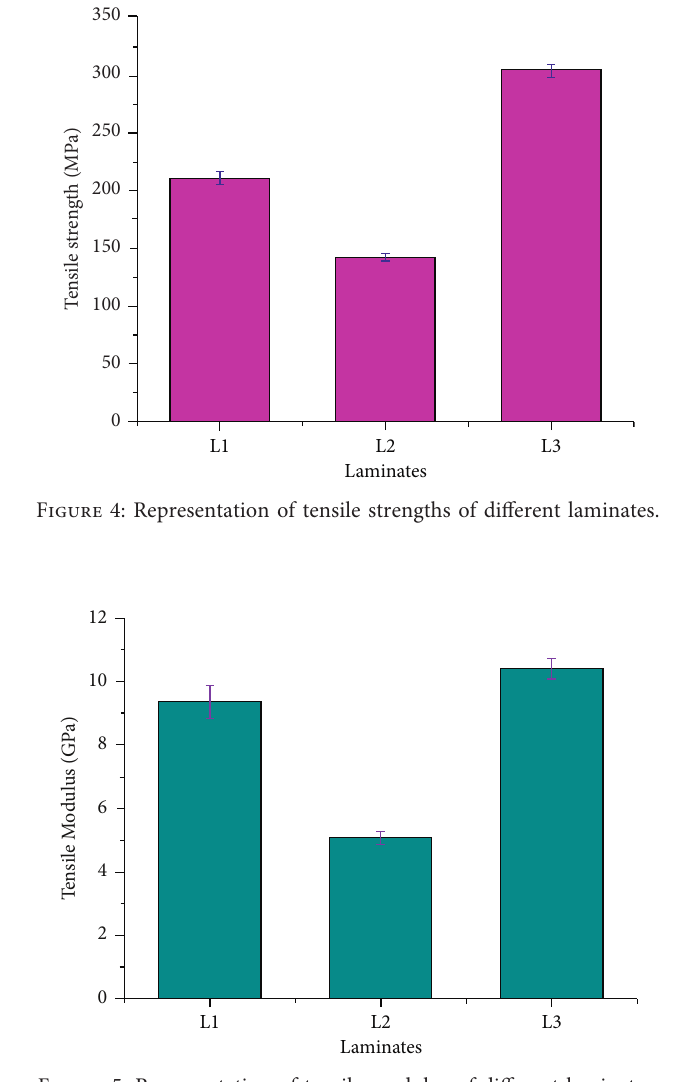
Figure 5: Representation of tensile modulus of different